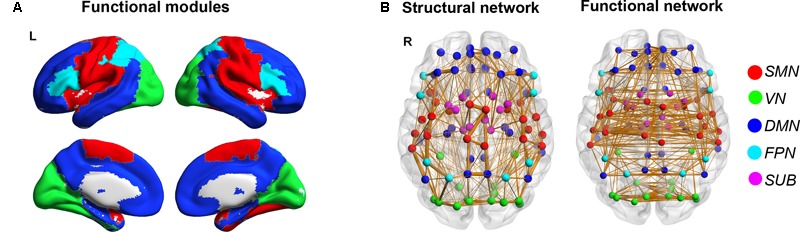
Modular organization of the functional brain connectome. Five functional modules were identified based on the functional backbone network, which are represented in five different colors overlaid on the cortical surface (A) and are shown on the backbones of SC and FC networks with different colors in nodes (B) (red: SMN; green: VN; blue: DMN; cyan: FPN; magenta: SUB).